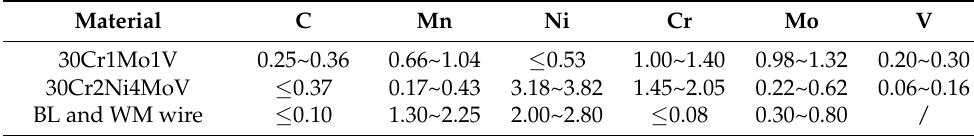
Table 1. Chemical composition of base metals and filler wires (wt.%).